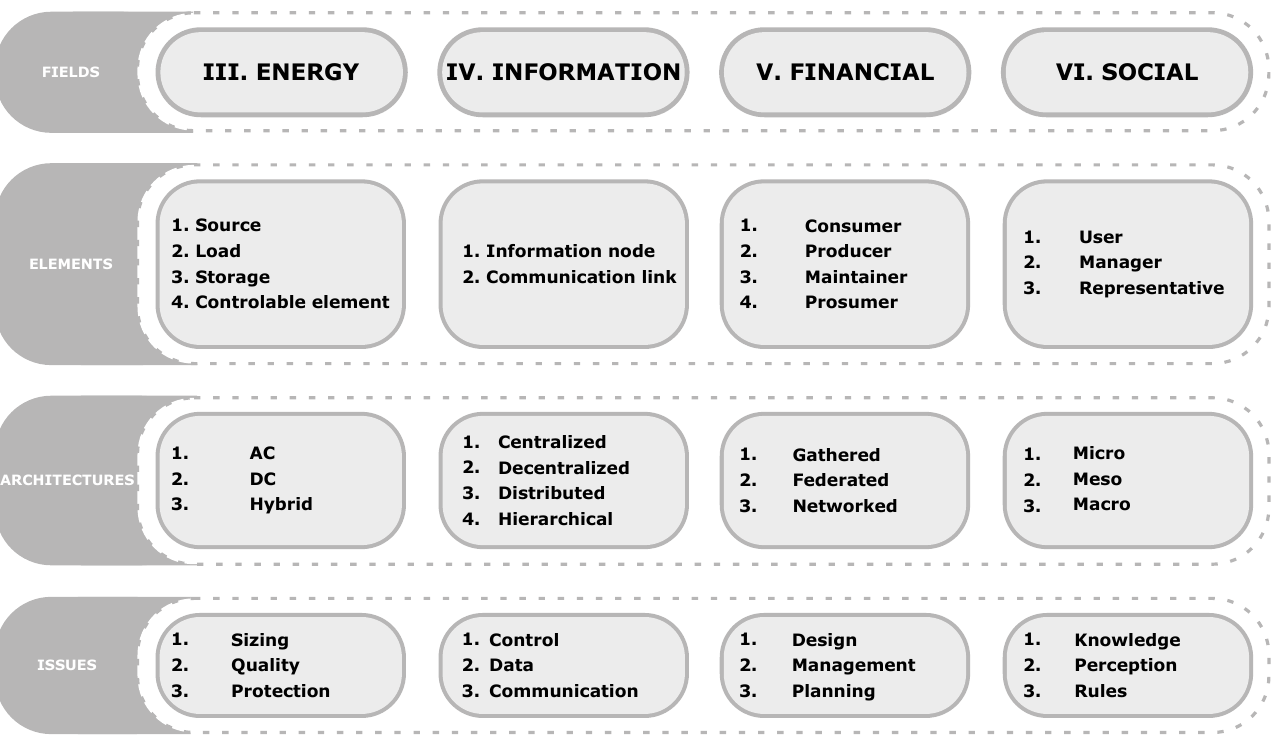
Figure 4. Structure of the